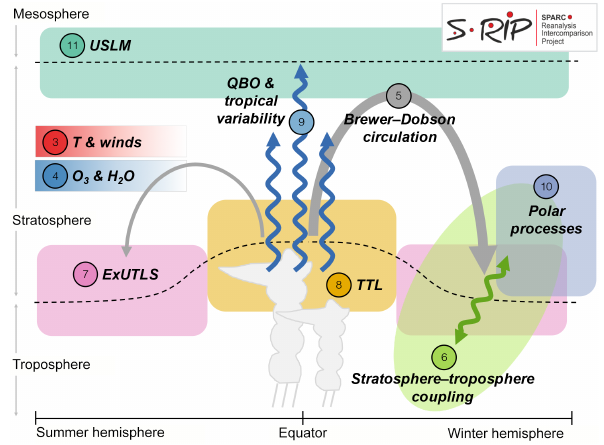
Figure 1. Schematic illustration of the atmosphere showing the pro- cesses and regions that will be covered by chapters in the planned full S-RIP report. Domains approximate the main focus areas of each chapter and should not be interpreted as strict boundaries. Chapters 3 and 4 cover the entire